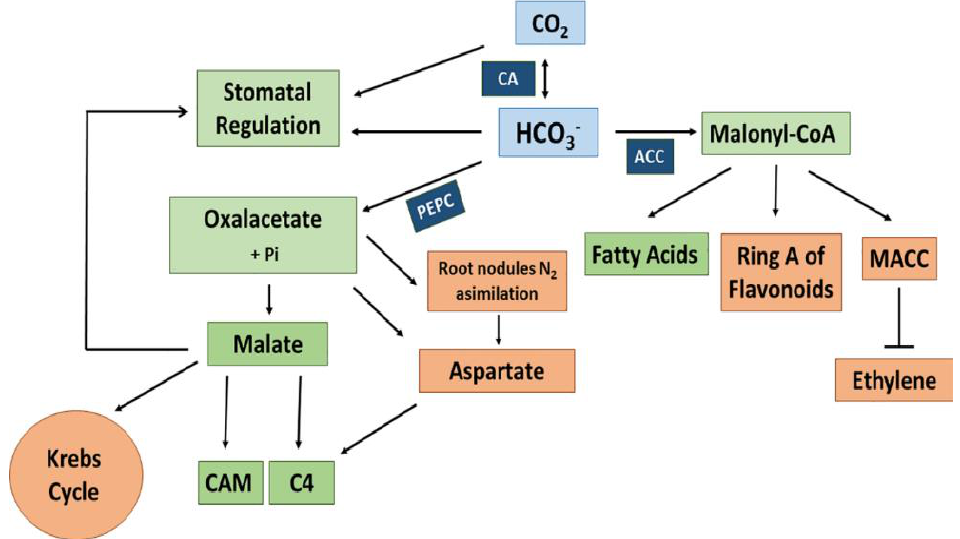
Figure 2. Metabolic pathways related to three major plant carboxylases using HCO 3 − as substrate. CA, carbonic anhydrase; PEPC, phosphoenolpyruvate carboxylase; ACC, acetyl-CoA carboxylase; MCC, malonyl-1-aminocyclopropane-1-carboxylic acid.